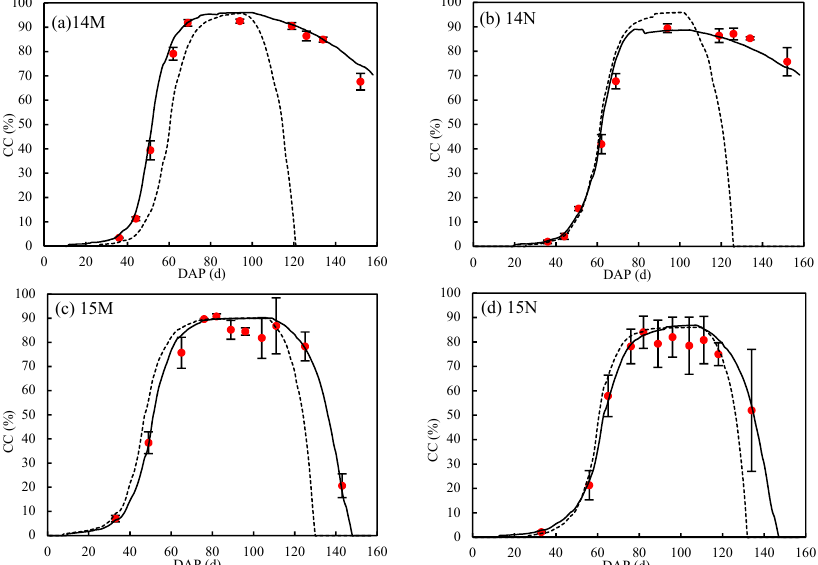
Figure 3. Simulated canopy cover ( CC ) using default (- - - - -) and calibrated (—) parameters and measurements ( ● ) of seed maize in 2014 and 2015. Table 3. Goodness-of-fit indicators between measurements and simulations for CC and accumulated evapotranspiration ( ET ) of seed maize for treatments with and without plastic film mulch (M and N) in 2014 and 2015.